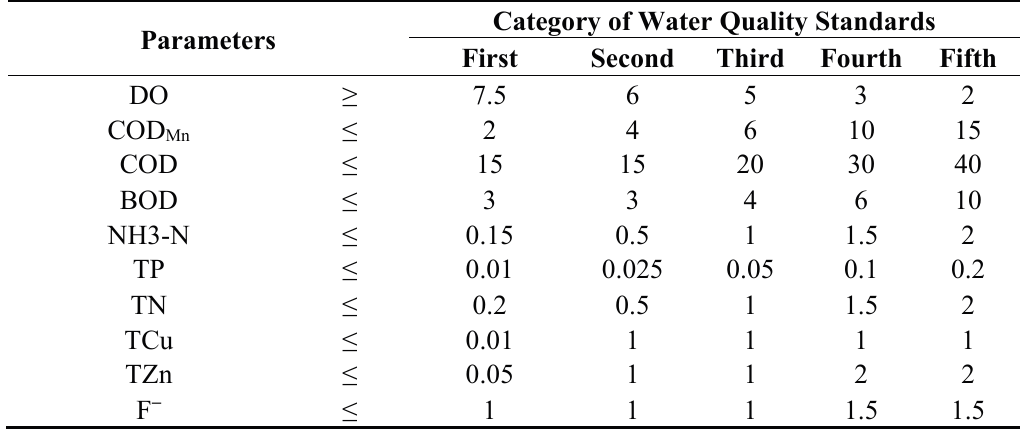
Table A1. Environmental guideline of national quality standards for surface waters, China (GB3838-2002) (units: